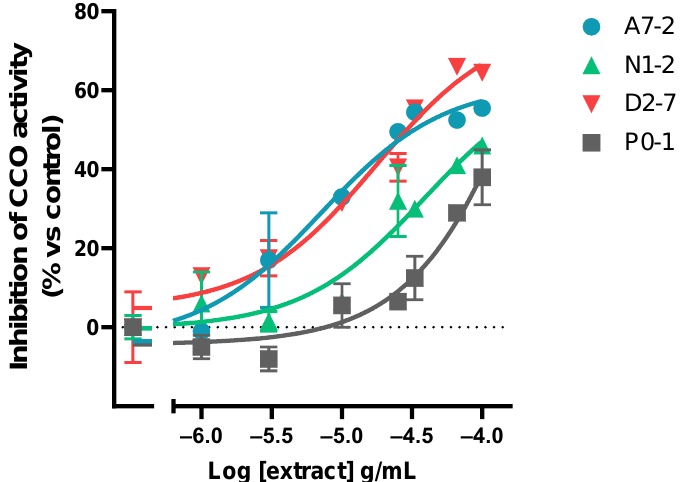
Figure 4. Representative graph of the cannabinoid extracts’ dose-dependent effect on the CCO activity expressed as a percentage over the basal activity in the presence of vehicle. Data are mean ± SEM values.